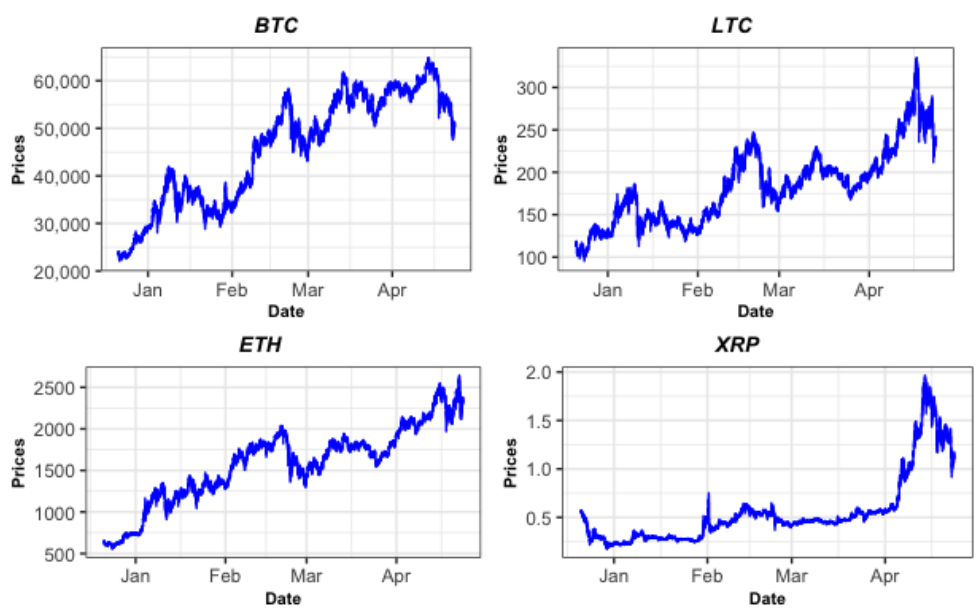
Figure 1. Cryptocurrencies’ sample prices. Note: Data observation time period: 21 December 2020 to